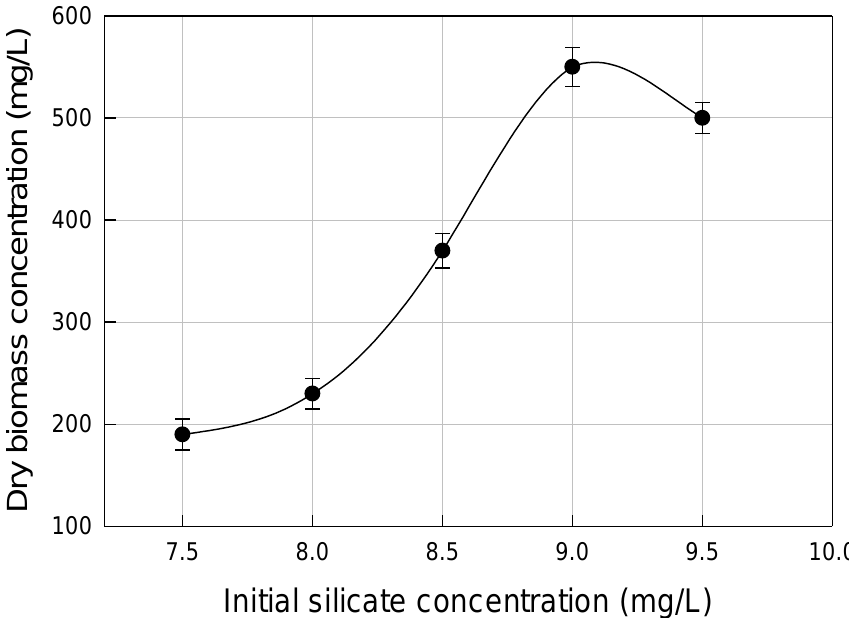
Figure 6. Dry cell mass concentration on day 15 in media with different initial silicate (as Na 2 SiO 3 · 9H 2 O) concentrations. Average values ± standard deviation based on five replicates. (Initial nitrate and phosphate concentrations were 1.75 mg L −1 (as NaNO 3 ) and 6.5 mg L −1 (as NaH 2 PO 4 H 2 O), respectively, in all experiments).